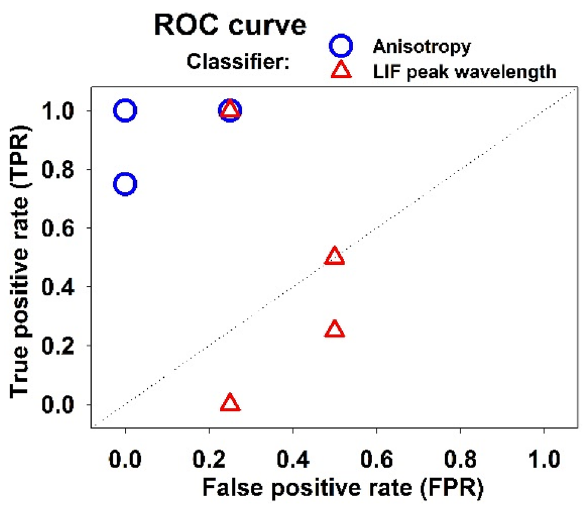
Figure 8. ROC in order to evaluate the anisotropy parameter as an accurate